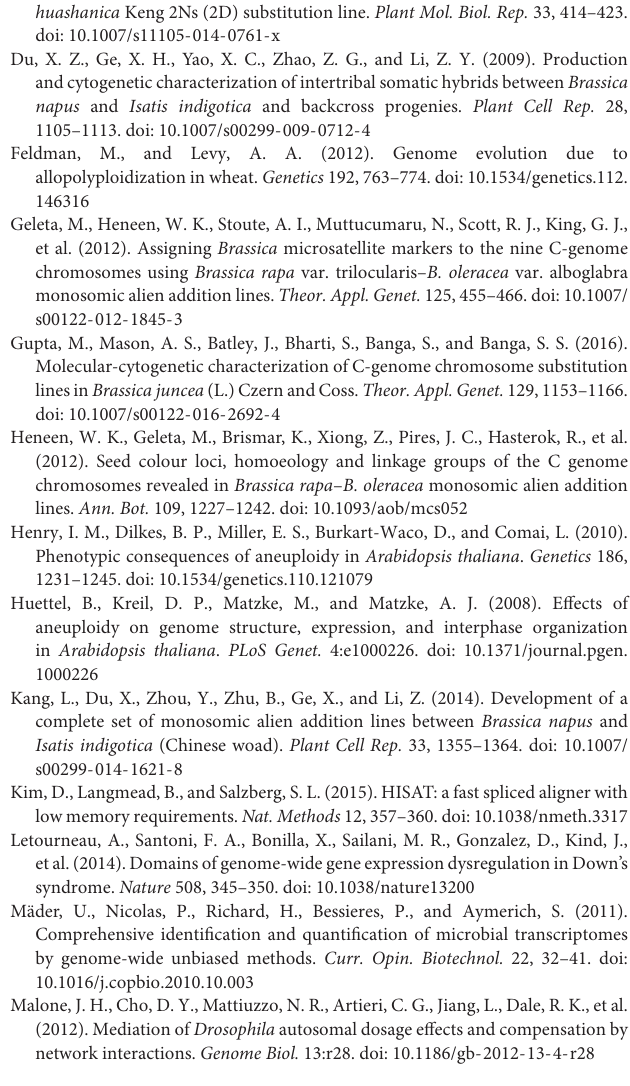
FIGURE S1 | GO analysis of total DEGs in two comparisons of RBR vs. C1 and RBR vs. Cs1. (A,B) The terms clustered for down-regulated genes in both comparisons. (C,D) The terms clustered for up-regulated genes. TABLE S1 | Trans -effects across all disomic chromosomes in the comparison of RBR vs. C1 and RBR vs.